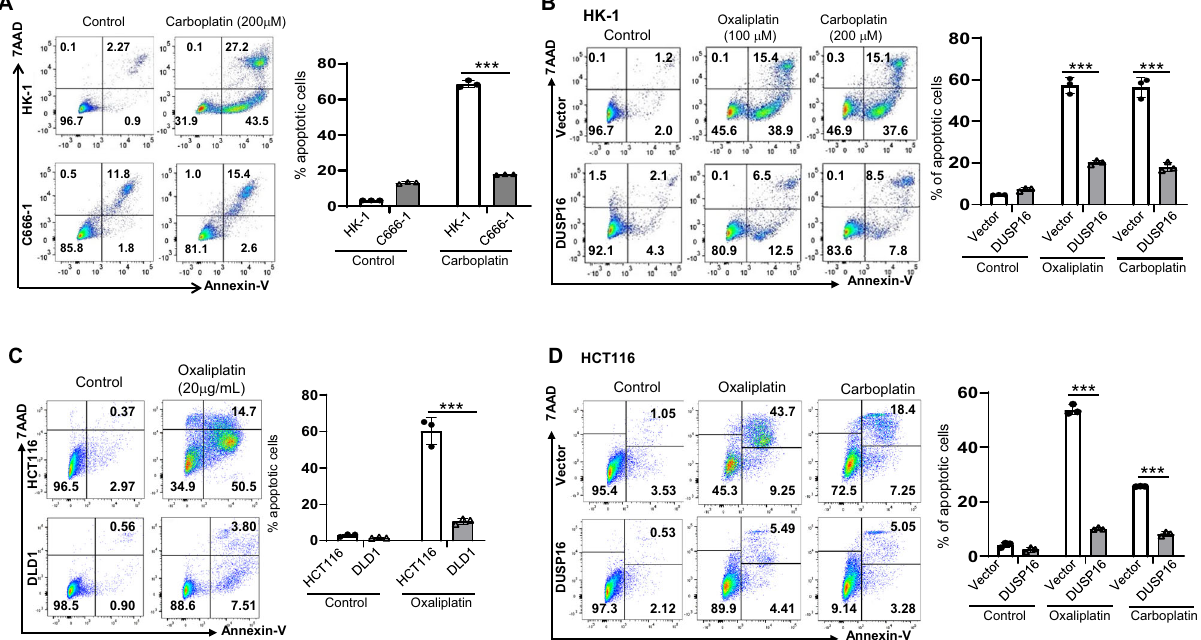
Fig. 3 Levels of DUSP16 in various types of cancer cells are associated with sensitivity to carboplatin and oxaliplatin. A Comparison of apoptosis induction between HK-1 and C666-1 cells in response to carboplatin treatment by fl ow cytometry analysis. Bar chart shows the percentage of apoptotic cells with mean values± standard error of the mean (SEM), n = 3 biologically independent samples. The data are representative of three experiments with similar results. Statistical analysis was performed using two-tailed unpaired t -test. *** P < 0.0001. B Comparison of apoptosis induction between vector- and DUSP16 -transfected HK-1 cells after oxaliplatin or carboplatin treatment by fl ow cytometry analysis. Bar chart shows the percentage of apoptotic cells (including both AnnexinV + 7AAD + and AnnexinV + 7AAD − cells) with mean values ± SEM, n = 3 biologically independent samples. The data are representative of three experiments with similar results. Statistical analysis was performed using two-tailed unpaired t -test. *** P < 0.0001. C Comparison of apoptosis induction between HCT116 and DLD-1 cells in response to oxaliplatin treatment by fl ow cytometry analysis. Bar chart shows the percentage of apoptotic cells with mean values± SEM, n = biologically independent samples. The data are representative of three experiments with similar results. Statistical analysis was performed using two-tailed unpaired t -test. *** P < 0.0001. D Comparison of apoptosis induction between vector- and DUSP16 - values ± SEM, n = 3 biologically independent samples. The data are representative of three experiments with similar results. Statistical analysis was performed using two-tailed unpaired t -test. *** P < 0.0001. Source data are provided as a Source data fi